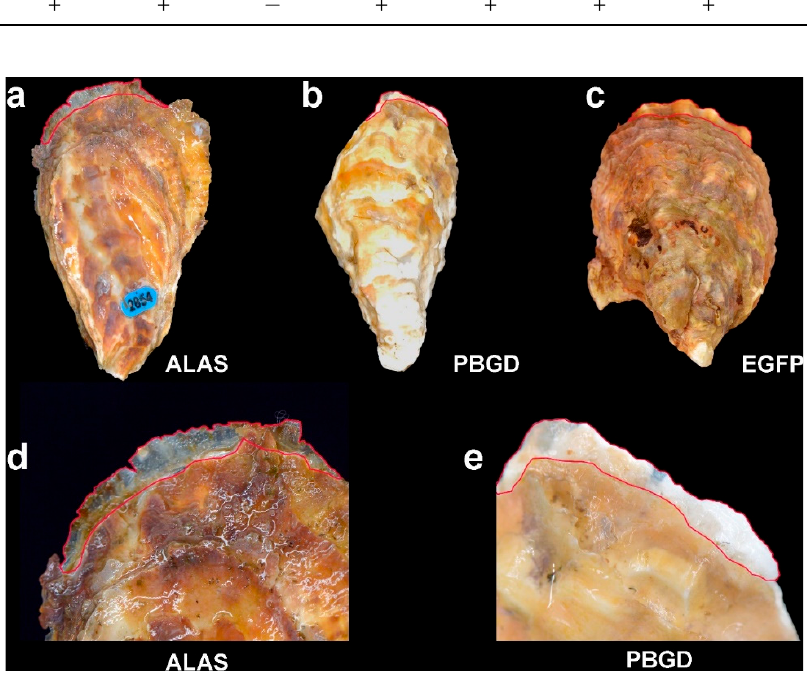
Figure 2. Analysis of pigmentation in newly deposited shell. Newly deposited shells are highlighted in red. ( a ) Photographic representation of C. gigas from group ALAS. ( b ) Photographic representation of C. gigas from group PBGD. ( c ) Photographic representation of C. gigas from group EGFP. ( d ) Bigger image for newly deposited shell C. gigas from group ALAS. ( e ) Bigger image for newly deposited shell C. gigas from group